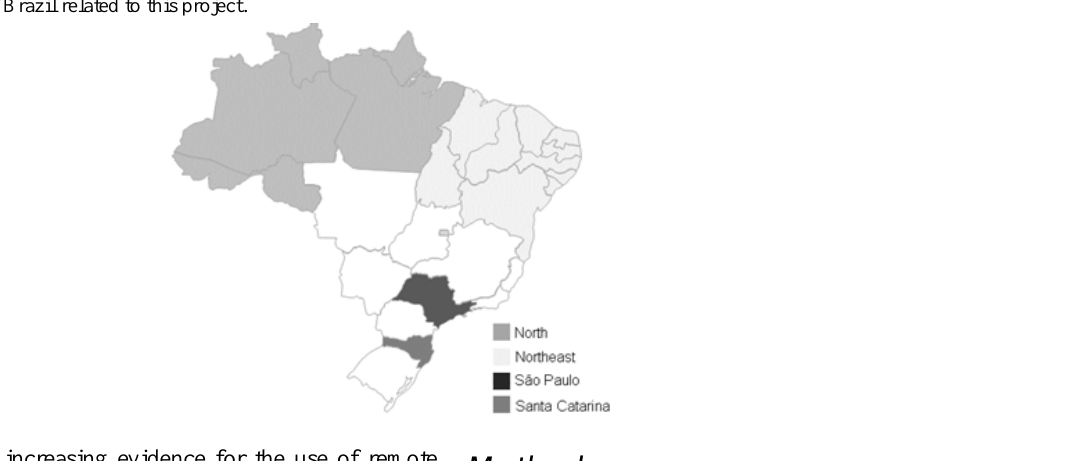
Figure 1. Regions of Brazil related to this